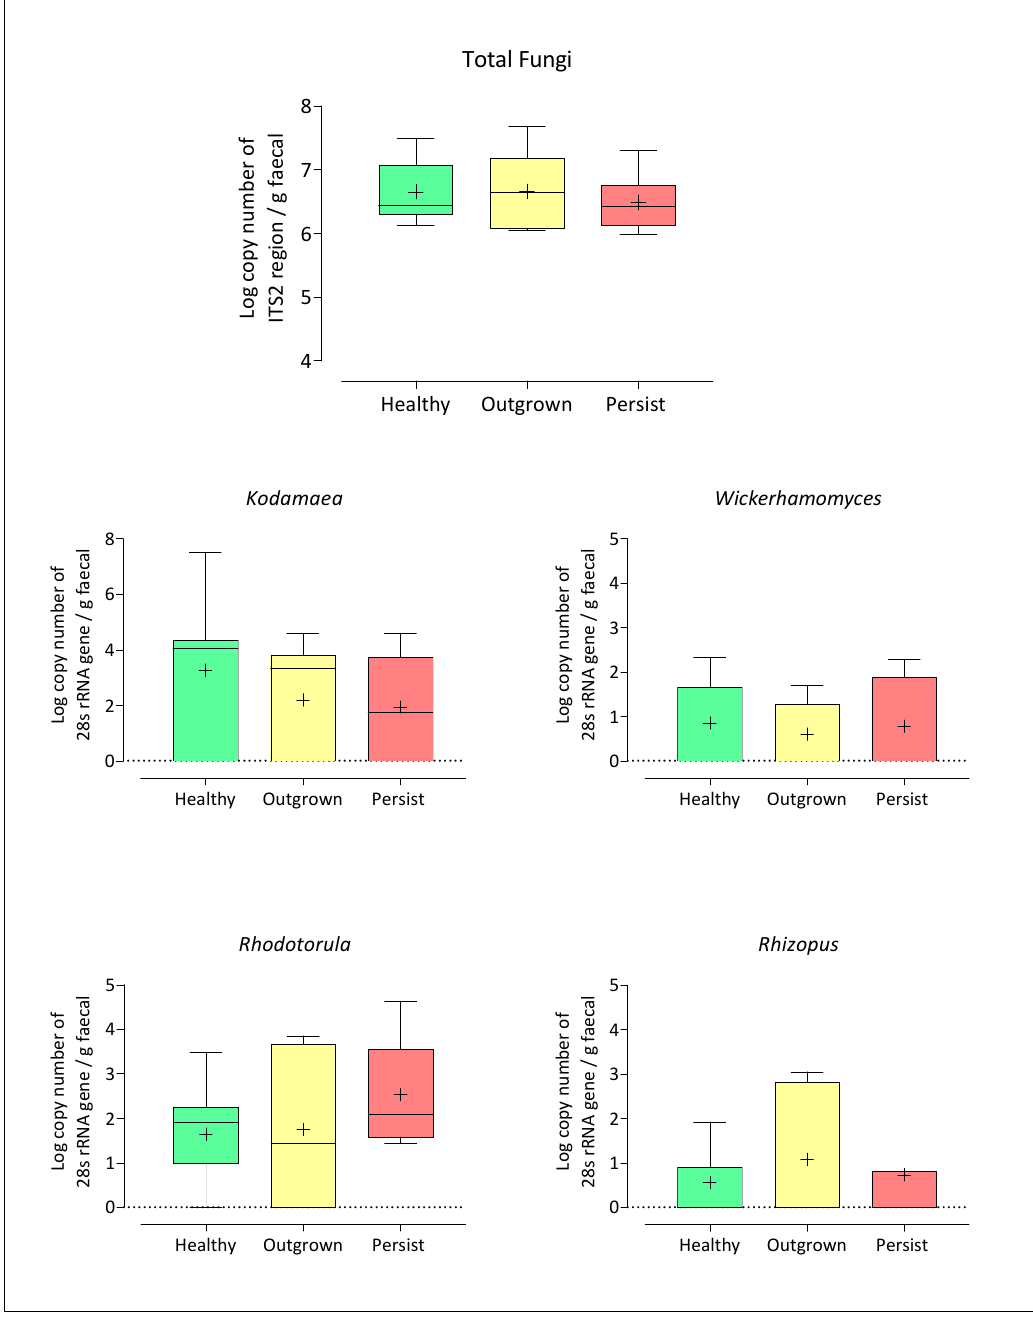
Figure 4. Quantification of altered total fungi and genera, including Kodamaea sp., Wickerhamomyces sp., Rhodotorula sp., and Rhizopus sp. The horizontal line represents the median value, while ‘+’ represents the mean value. There was no statistically significant difference between the three groups ( p > 0.05).